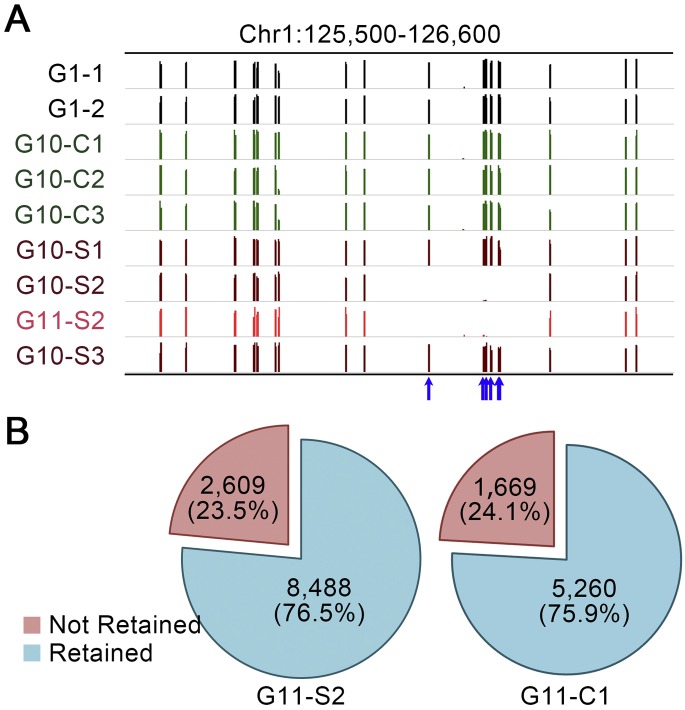
Stability of inheritance of CG-DMPs accumulated during multigenerational propagation on saline soil. Comparisons of methylation status at CG-DMPs in genomes of G10 and G11 plants. (A) IGV views of methylation level differentials. Column height indicates the relative extent of methylation at individual CG positions in G1 (black), control G10 (green), saline soil G10 (dark red), and saline soil G11 (red) genome samples in a specific region of chromosome 1. The blue arrows highlight example CG-DMPs where methylation has been lost in one of the saline soil G10 samples (G10-S2). Absence of methylation at these CG-DMPs is retained (stably inherited) in the subsequent generation, in the G11-S2 genome sample (see Supplemental Fig. S3). (B) Overall frequencies of retention of methylation status in G11 plants. CG-DMPs identified in G10 plants (G10-S2 or G10-C1) are shown as Retained (unchanged methylation status [stably inherited] in G11-S2 or G11-C2) or as Not Retained (where methylation status differs between G10 and G11 genomes).